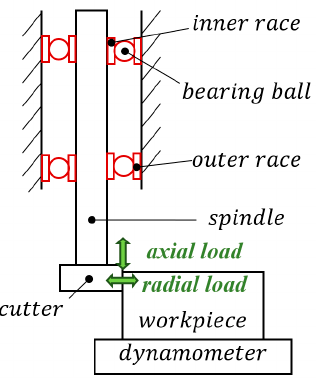
Figure 7. Schematic diagram of spindle parts under load.